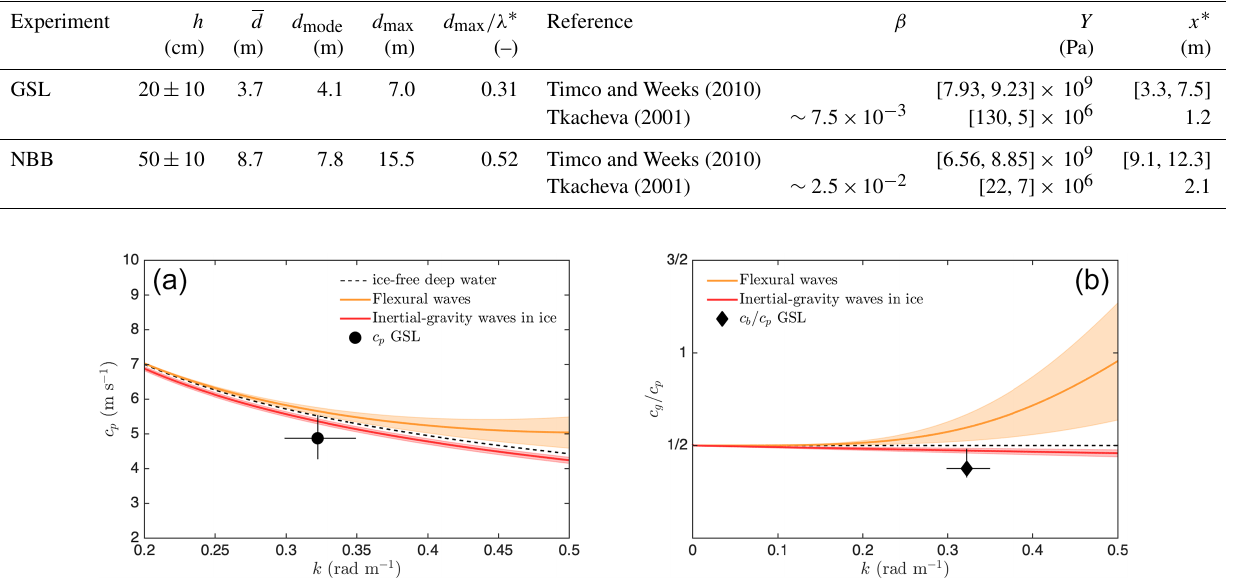
Figure 11. Phase speed (a) and the ratio between the group speed and the phase speed (b) as a function of wavenumber k for ice-free deepwater waves (dash line), pure flexural waves (orange, Eq. 16 with ρ i = 0) or pure inertial-gravity waves (red, Eq. 16 with Y = 0). The mean and extreme values for ice thickness ( h ) and Young’s modulus ( Y ) are those from Fig. 10 and Table 2. The black diamond indicates the ratio between the breakup speed ( c b ) and the measured phase speed ( c p ) in the GSL experiment, with the uncertainties described in Table